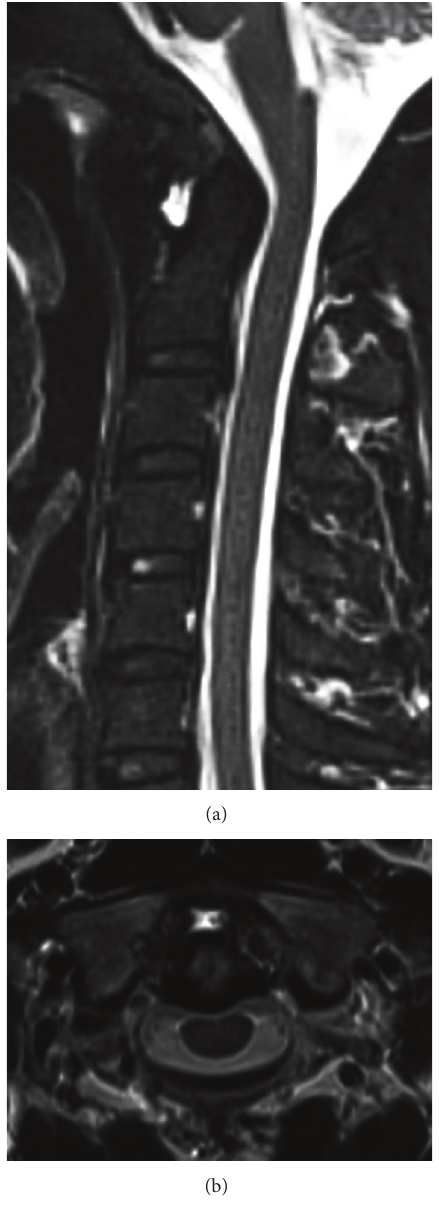
Figure 3: Cervical spine MRI. In (a) sagittal and (b) axial T2- weighted images, the high intensity area suggested fluid accumula- tion between the anterior arch of the atlas and odontoid process of the